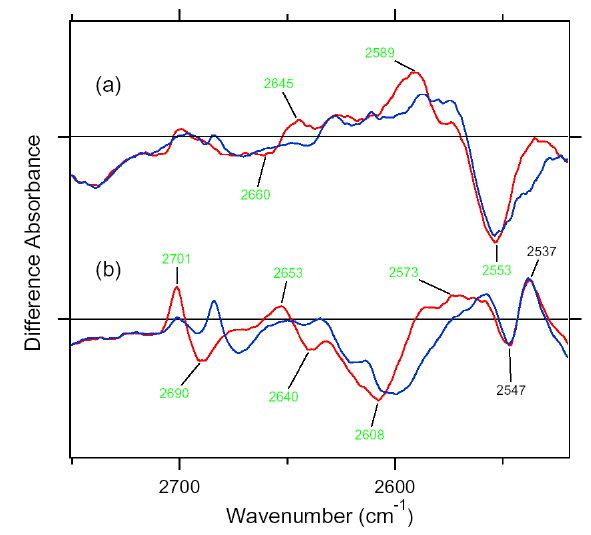
Figure 20. The 13C-ASR minus 13C-ASR (a) and the AT-ASR minus AT-ASR (b) K K spectra (pH 7) in the 2,750–2,520 cm -1 region measured at 77 K. Sample was hydrated with D O (red line) or D 218 O (blue line). Green-labeled frequencies correspond to those identified 2 as water stretching vibrations. One division of the y-axis corresponds to 0.0004 absorbance units. This figure is reprinted with permission from Kawanabe et al. [59]. Copyright 2006 American Chemical